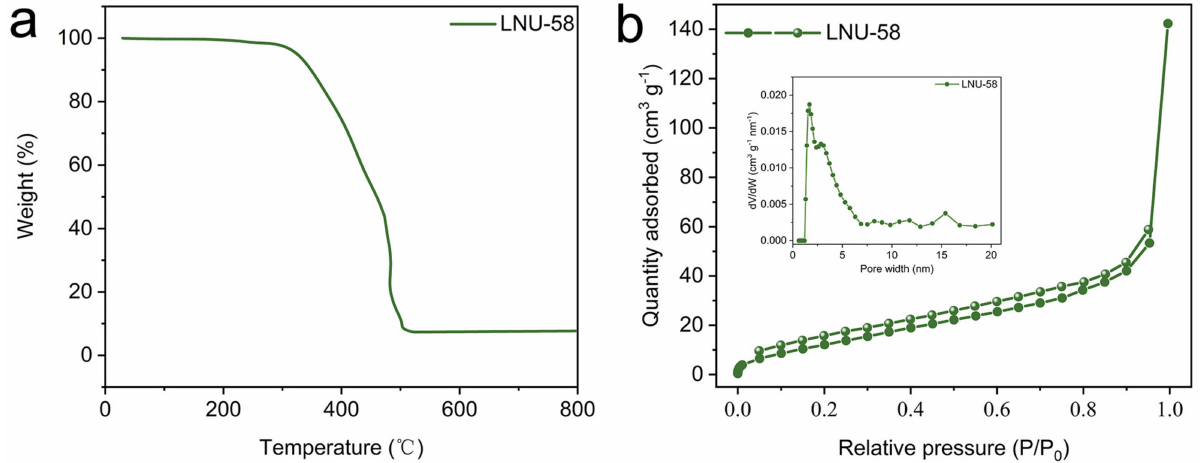
Figure 3. ( a ) TGA plot for LNU-58 under air atmosphere condition; ( b ) N 2 adsorption–desorption isotherm of LNU-58 at 77 K, pore size distribution of LNU-58